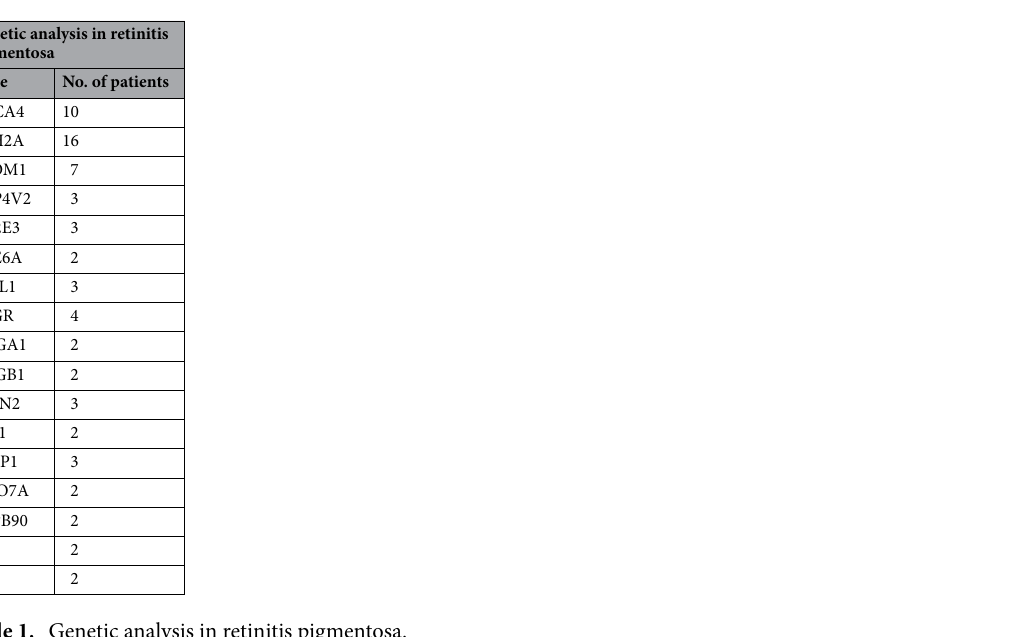
Table 1. Genetic analysis in retinitis